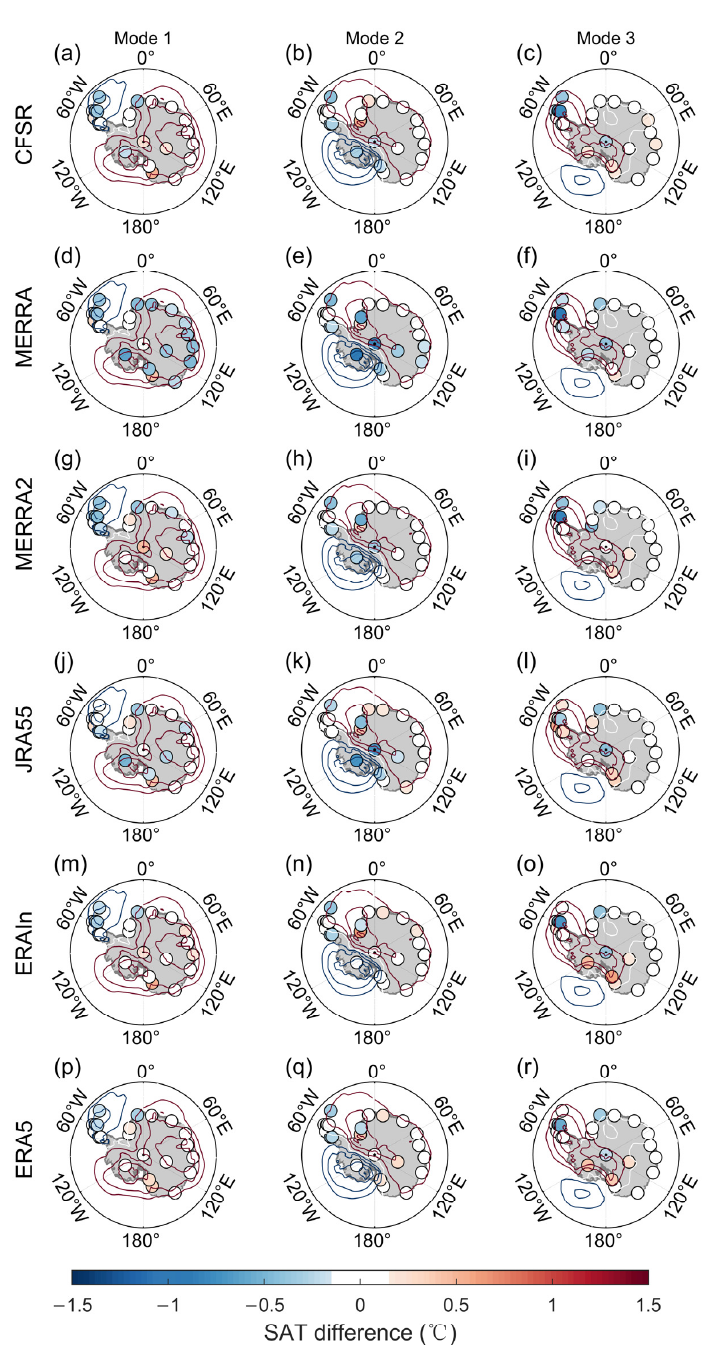
Figure 6. The difference in the combined maximum covariance analysis (CMCA) spatial patterns between reanalyses and observations at the in situ observation locations for each reanalysis dataset and CMCA mode. The color dots show the difference in the spatial pattern between reanalyses and observations (reanalyses minus observations). The contours depict the spatial pattern of EnMean for CMCA Mode1 ( a , d , g , j , m , p ), Mode2 ( b , e , h , k , n , q ), and Mode3 ( c , f , i , l , o , r ). The contour intervals are 0.5 °C.